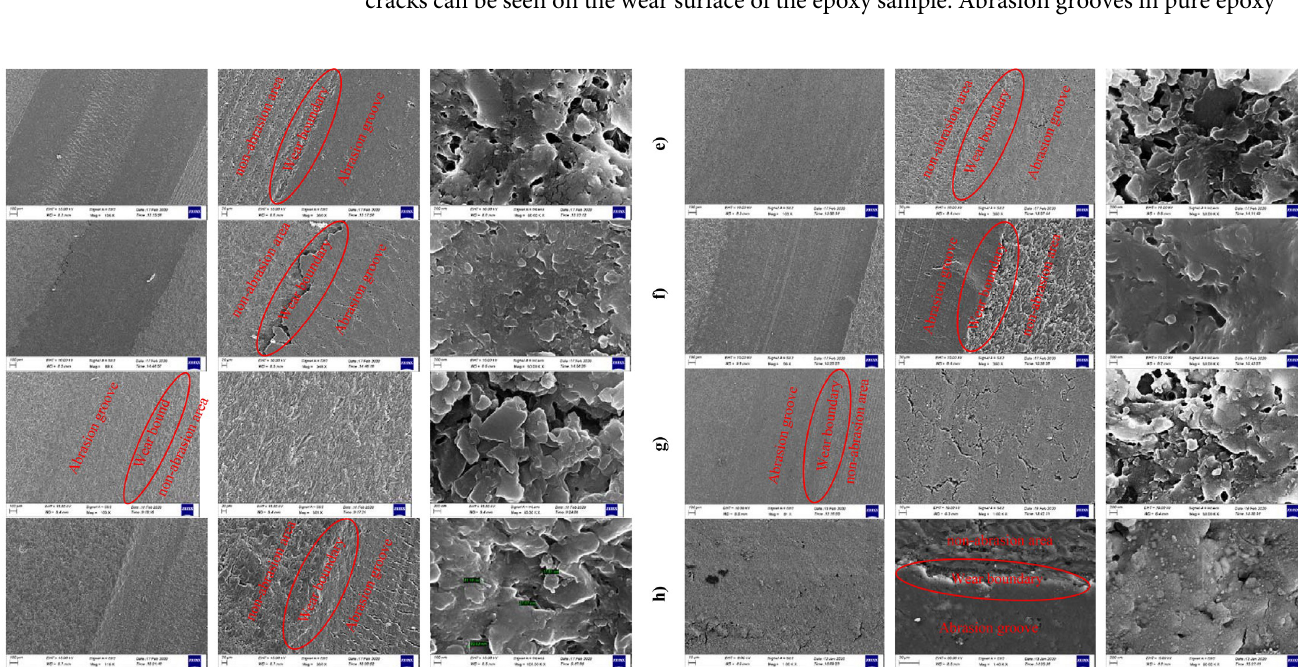
PLOS ONE | https://doi.org/10.1371/journal.pone.0259401 November5,